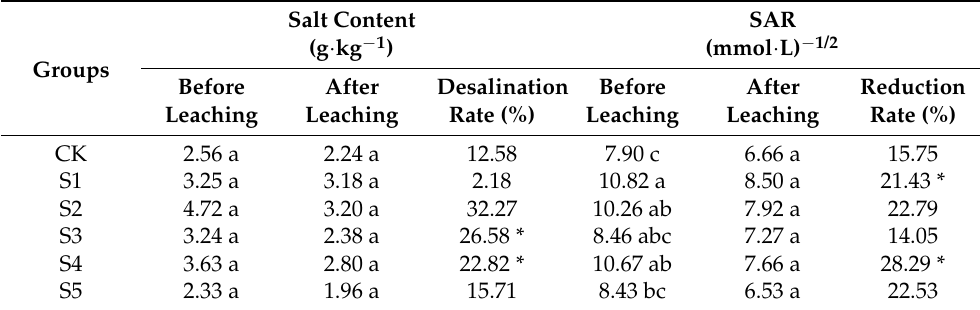
Table 6. The average salt content and sodium adsorption ratio in the soil